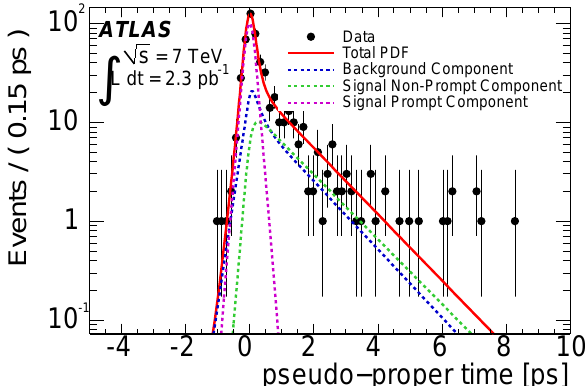
µ + µ − candi- Fig. 1. Pseudo-proper time distribution of J /ψ → dates in the signal mass region, for 9 . 5 < p T ( J /ψ ) < 10 . 0 GeV y J /ψ < 0 . 75. The points represent measured data, the solid and | | line is the result of an unbinned maximum likelihood fit to all di- muon pairs in the 2 . 5 3 . 5 GeV mass region projected onto the − pseudo-proper lifetime